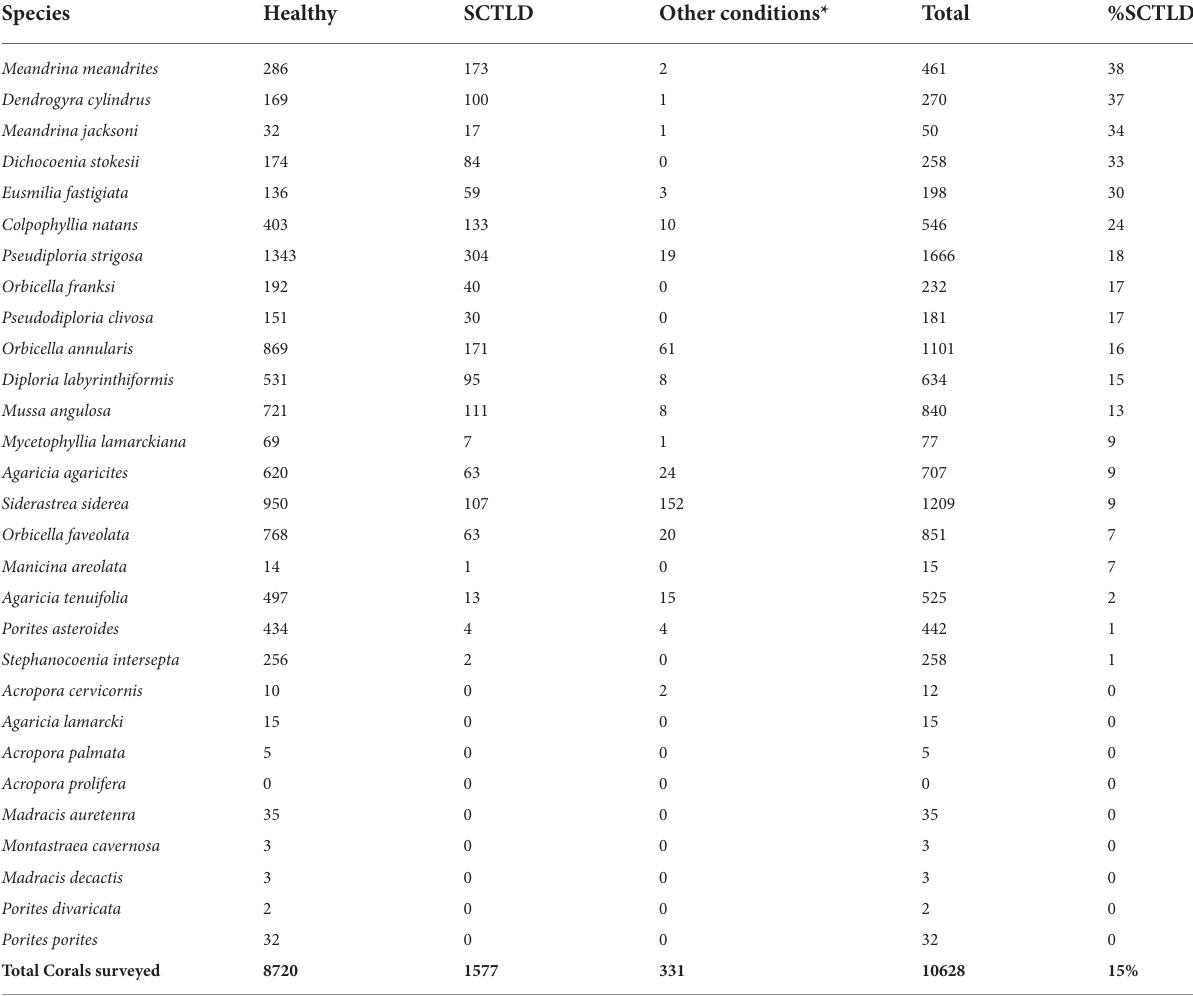
TABLE 2 List of coral species surveyed in Honduras highlighting species health and showing prevalence of SCTLD within colonies. Species Healthy SCTLD